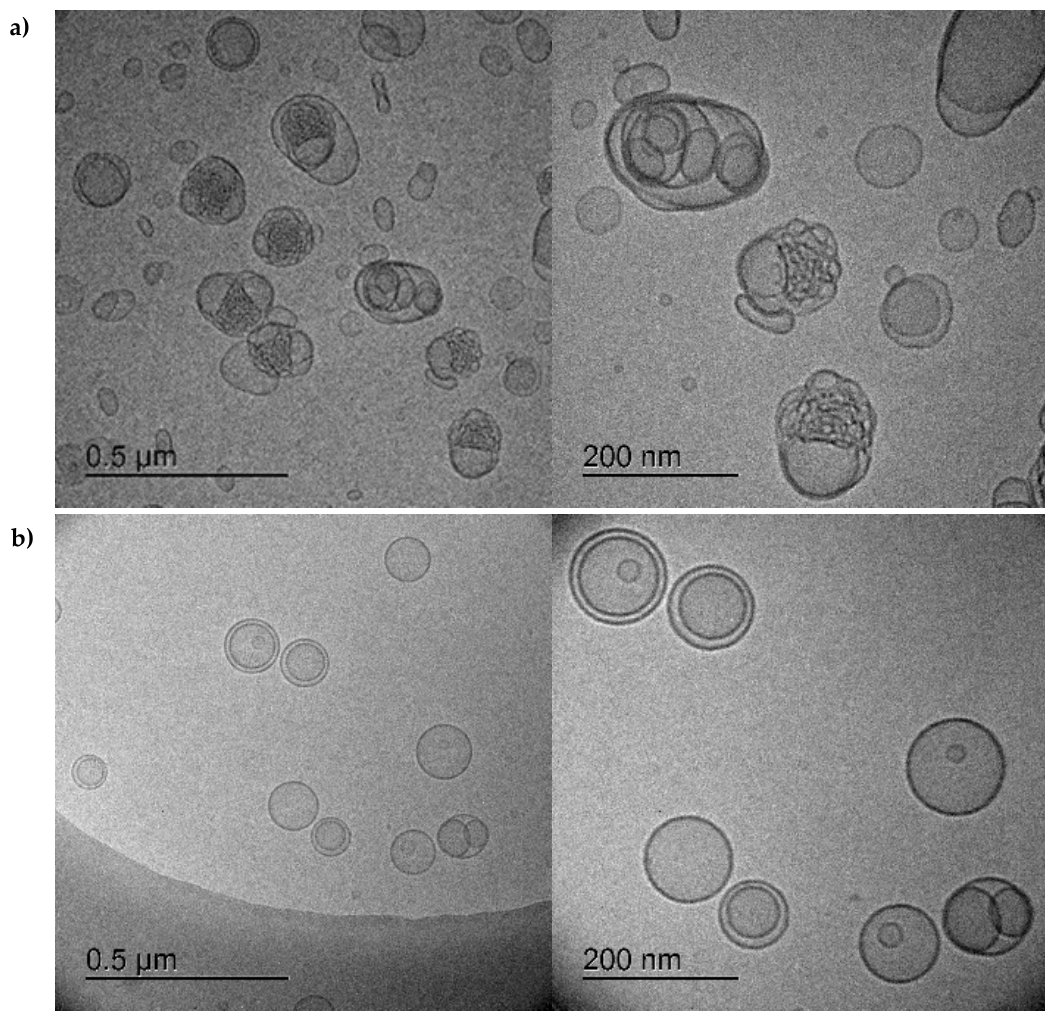
Figure 4. Cryo -TEM images of liposomes loaded with HIPS5031 : ( a ) DOPG/CL liposomes loaded by rehydration of a pure lipid film with a drug-PBS solution. The altered morphology of vesicles indicates drug precipitation, aggregation, and vesicle fusion due to unsuccessful loading. ( b ) DOPG/CL/Chol liposomes loaded by rehydration of a drug containing dry lipid film (PBS). Oligolamellar vesicles are characterized by a smooth surface and homogenous size distribution (after SEC) without signs of instability, suggesting drug accumulation in the lipid bilayer.